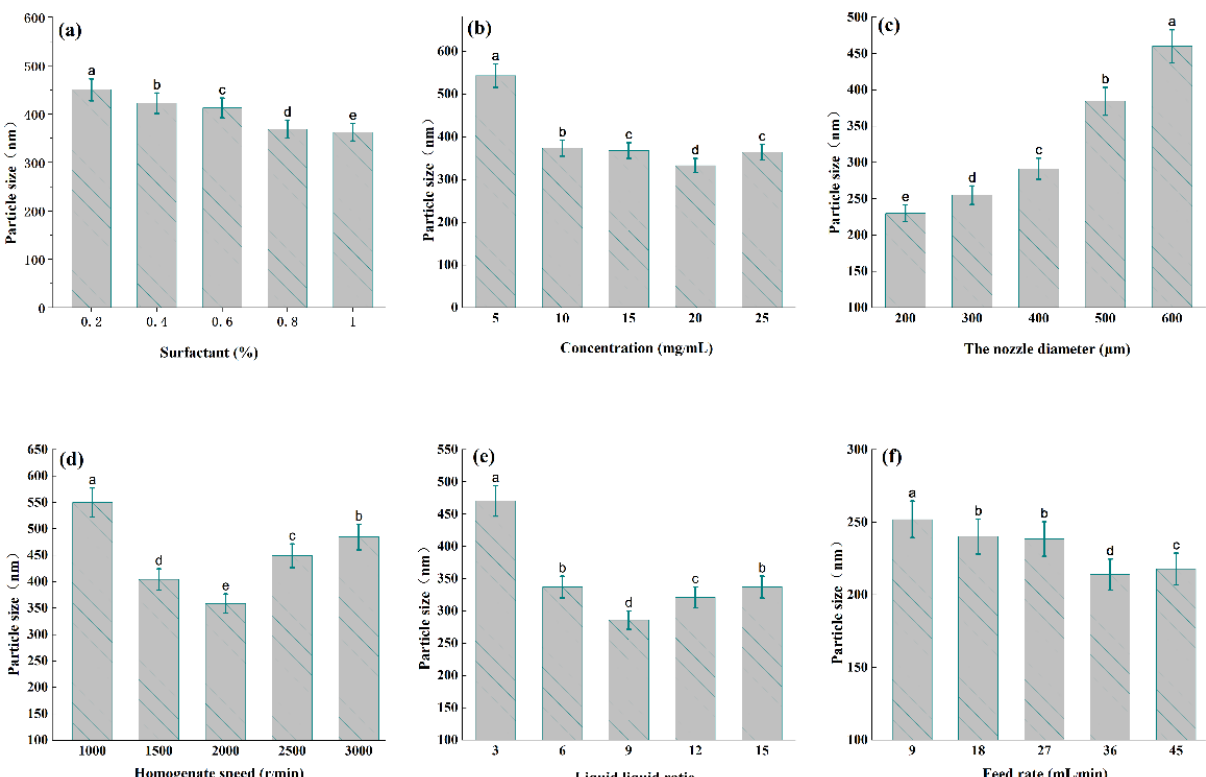
Figure 2. Influence of various factors on NUP size (( a ): surfactant %, ( b ): concentration mg/mL, ( c ): nozzle diameter μ m, ( d ): homogenizer speed r/min, ( e ): liquid-liquid ratio, ( f ): feed rate mL/min). The different letters (a–e) indicate significant differences among all samples ( p <